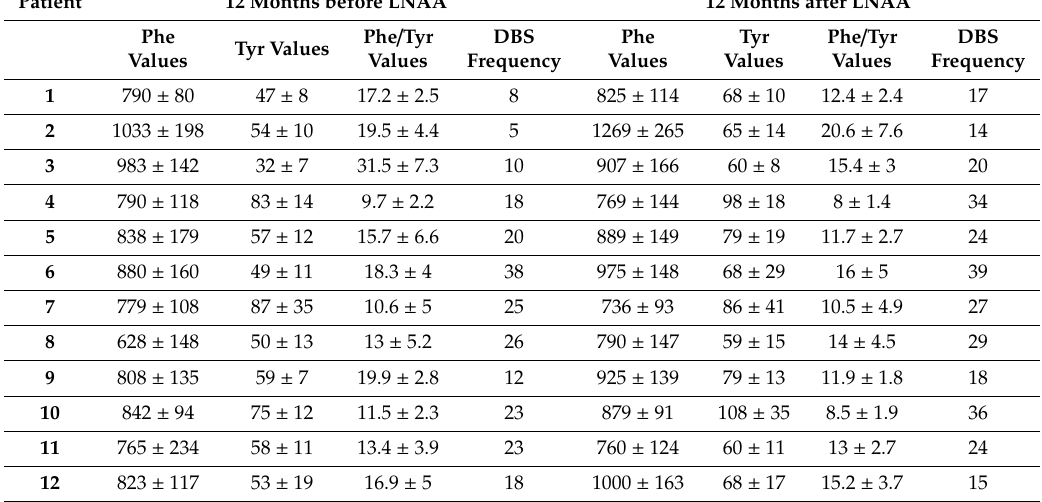
Table 2. Phenylalanine (Phe), tyrosine (Tyr), and Phe / Tyr ratio and frequency of dried blood spots (DBS) of each patient, before and after the introduction of large neutral amino acid (LNAA) treatment. Patient 12 Months before LNAA 12 Months after LNAA Phe Phe / Tyr DBS Phe Tyr Values Values Values Frequency Values